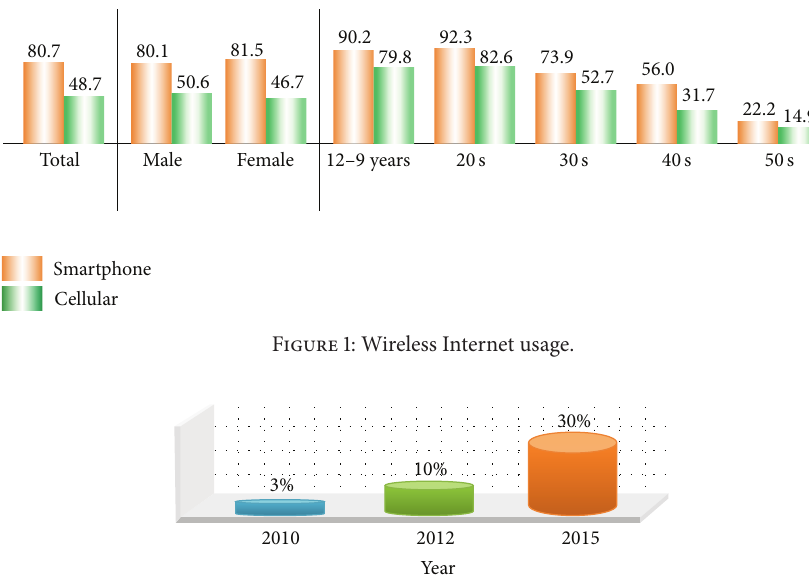
Figure 2: Smart work creates an environment of workers of 30% in